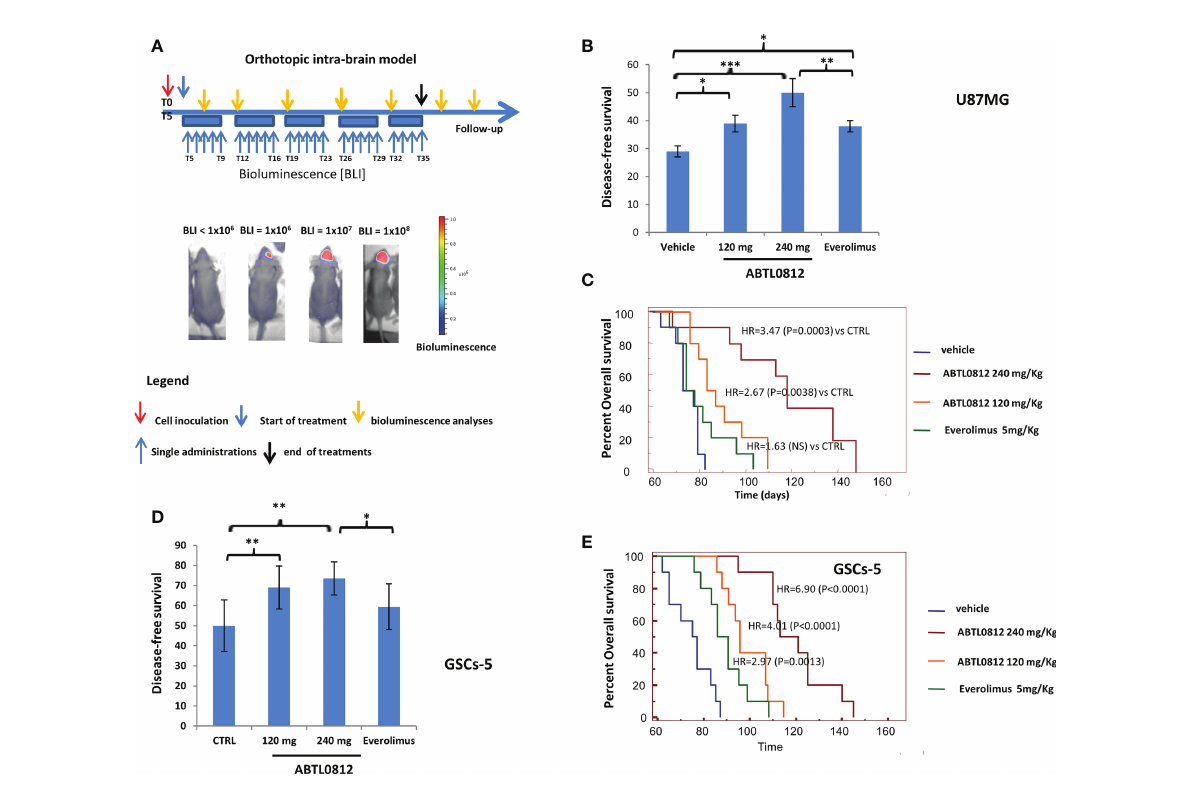
FIGURE 7 ABTL0182 inhibits tumor growth in an orthotopic model of glioblastoma in mice that reproduces the clinical setting after surgical removal of tumors. (A) Diagram showing the experimental design of the treatment of glioblastoma orthotopic models using U87MG and GSCs-5 luciferase- tagged cells ortotopically inoculated into the brain of athymic nude mice and treated with ABTL0812 (120 and 240 mg/Kg) and Everolimus (5 mg/Kg). Tumors were monitored by bioluminescence detection which was performed every 7 days in order to determine Disease Free Survival (DFS) and Overall Survival (OS). (B) DFS of mice bearing orthotopic tumor of U87MG-Luc cells. (C) Overall survival of mice bearing U87MG-Luc cells orthotopic tumors. (D) DFS of mice bearing orthotopic tumor of GSC-5 -Luc cells. (E) Overall survival of mice bearing GSC-5 -Luc cells orthotopic tumors. Statistical signi fi cance levels: *p<0.05, **p<0.01, ***p<0.01 n=10 in each group. CTRL= control vehicle-treated